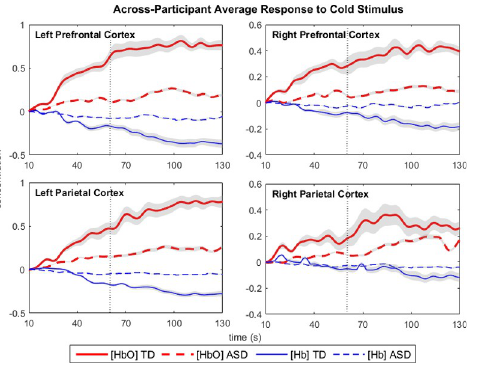
Fig 6. Average across-participant brain response to noxious cold stimulus for each study group in the left prefrontal, right prefrontal, left parietal and right parietal cortices. Average oxygenated and deoxygenated hemoglobin ([HbO] and [Hb], respectively) responses are plotted with shaded areas representing standard error the mean for each time point. Dashed vertical lines indicate the 60s mark of the